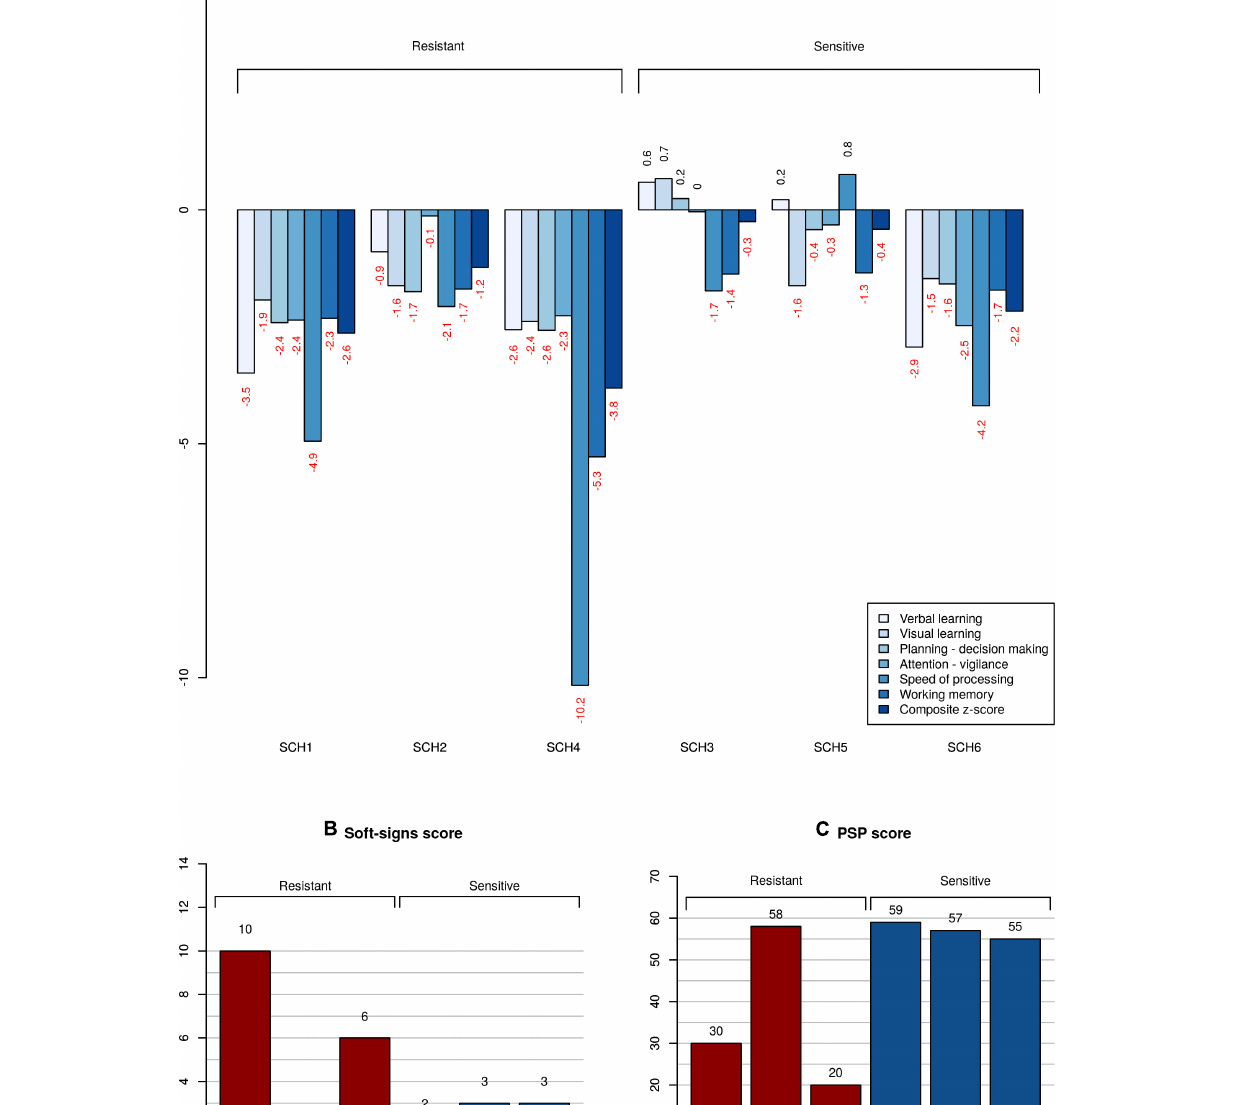
involved in retrograde endocannabinoid signaling,